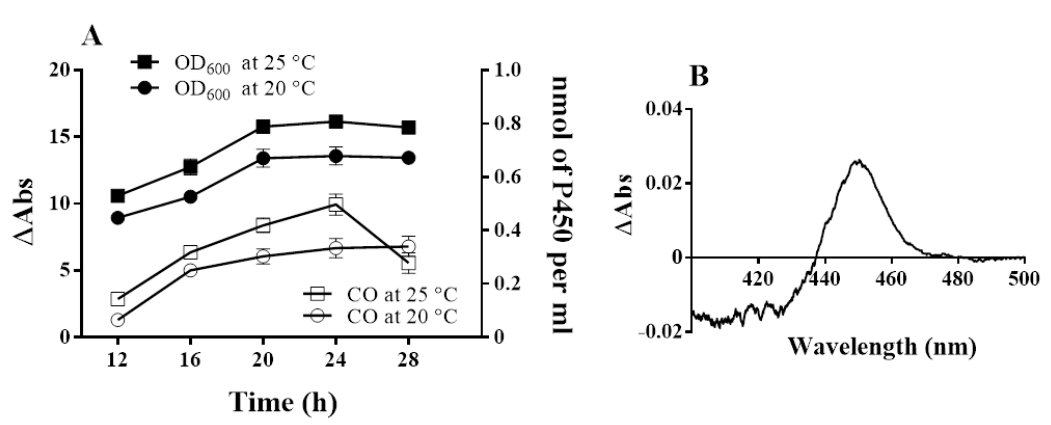
Figure 4. Optimal expression of CYP102A1 M221 mutant in the E. coli strain MG1655. ( A ) The cultures were grown at 20 or 25 °C up to 28 h. OD 600 and P450 concentration were measured at indicated time. ( B ) CO-difference spectrum of M221 at 24 h culture time at 25 °C.